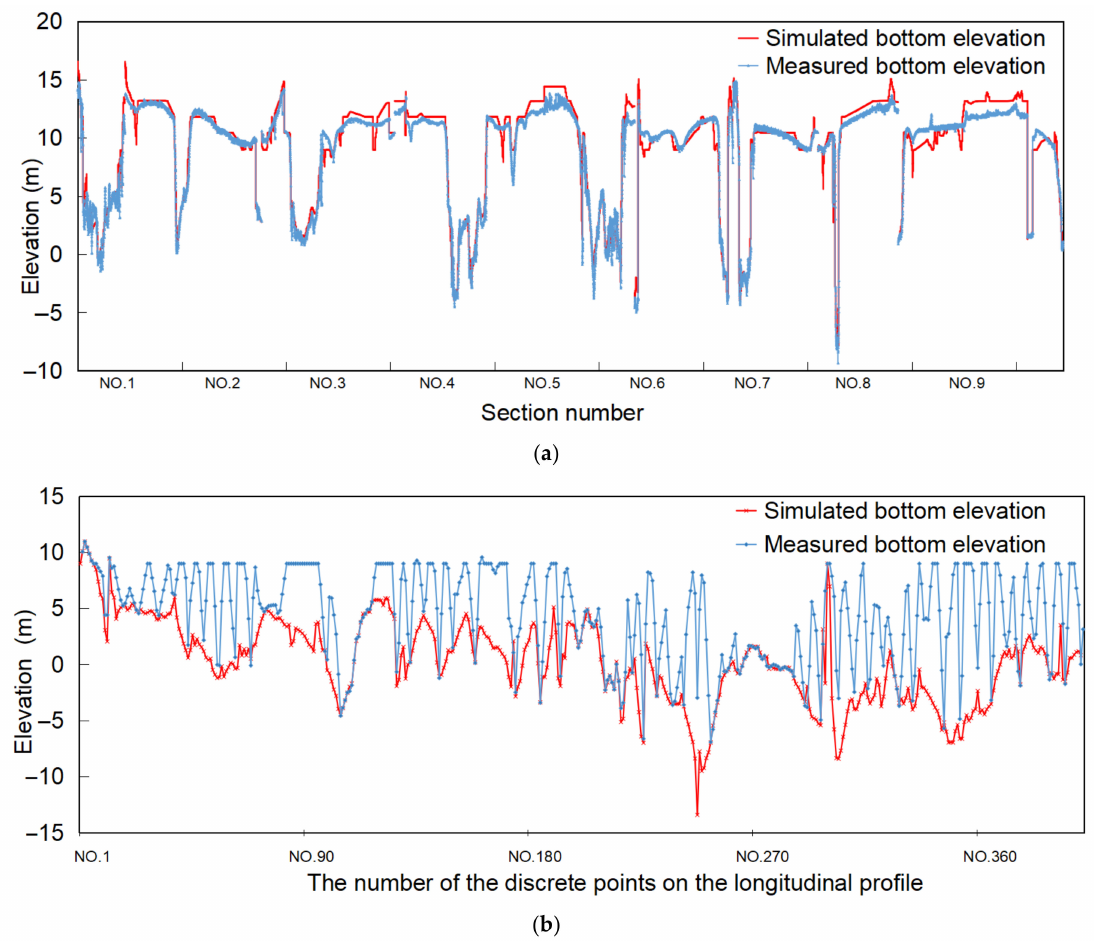
Figure 4. Bathymetric accuracy evaluation: ( a ) accuracy comparison of the cross-section; ( b ) continu- ity of the longitudinal river